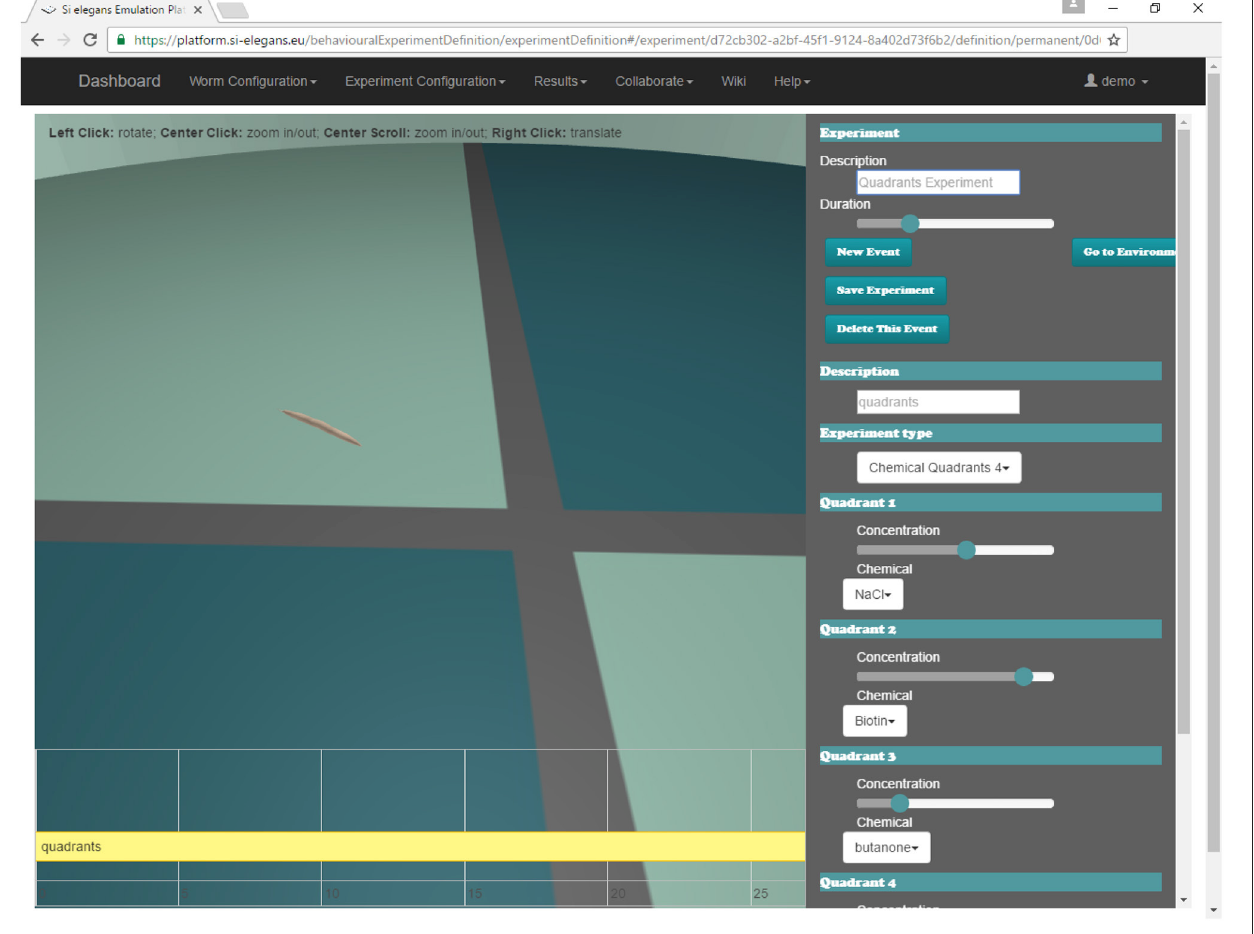
FIGURE 8 | Chemosensation quadrants behavioral experiment being defined in the web GUI